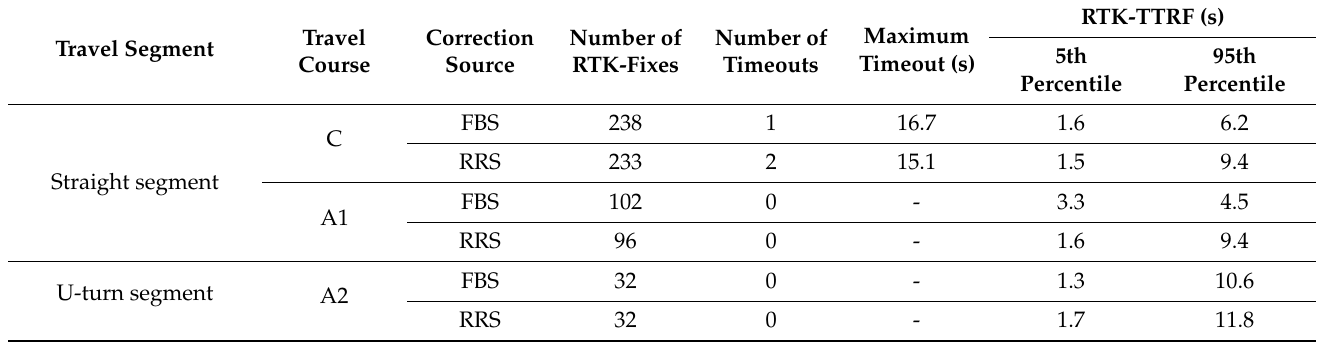
Table 3. Measurement results for the dynamic RTK-TTRF in different correction sources.